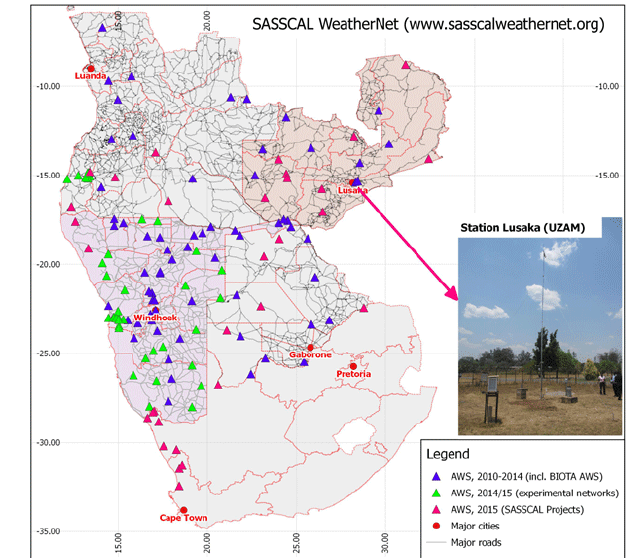
Figure 3. Location of observing stations supported by SASSCAL (including stations installed by BIOTA AFRICA). Data from these stations are available at www.sasscalweathernet.org. Note: Addi- tional five AWS will be installed within a radius of 20km South East of Gaborone City, i.e. upstream of Gaborone